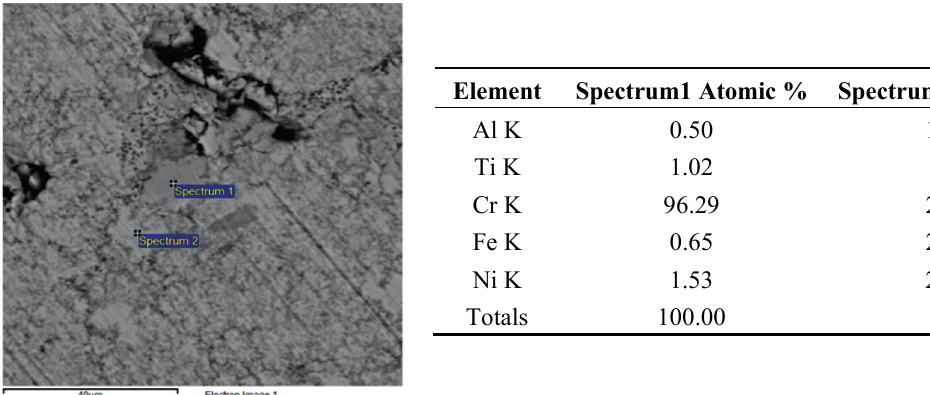
Figure 9. Backscattered electron SEM micrographs and EDS elemental analysis of the FeCrNiTiAl areas indicated by “Spectrum 1” and “Spectrum 2” after microwave heating at 700 W, 2450 MHz, in regions of the predominant electric field of the applicator (forming pressure = 300